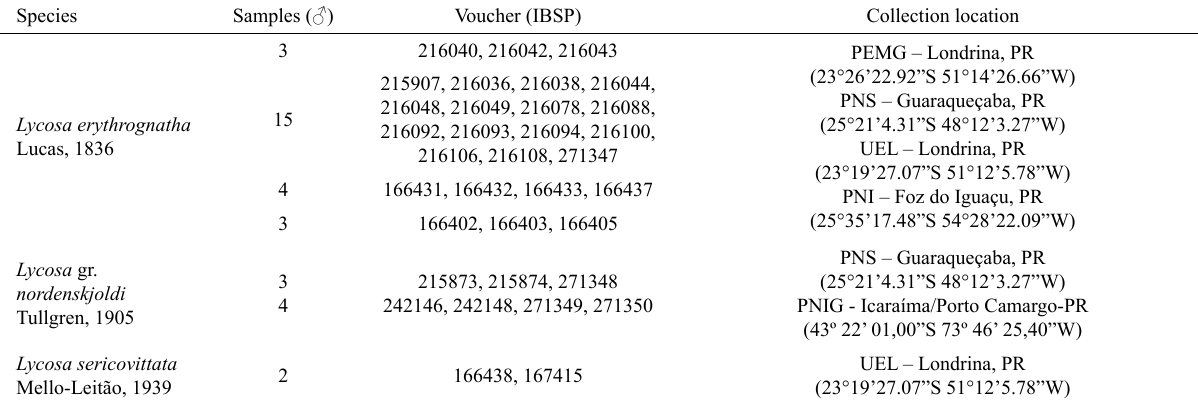
Table 1 – Species analyzed and collection sites. IBSP = Collections Laboratory Zoos, Butantan Institute (curator AD Brescovit), São Paulo / SP, Brazil; PR = Paraná; PEMG=Mata dos Godoy State Park; PNS=Superagui National Park; UEL= State University of Londrina; PNIG=Ilha Grande National Park; PNI = Iguaçu National